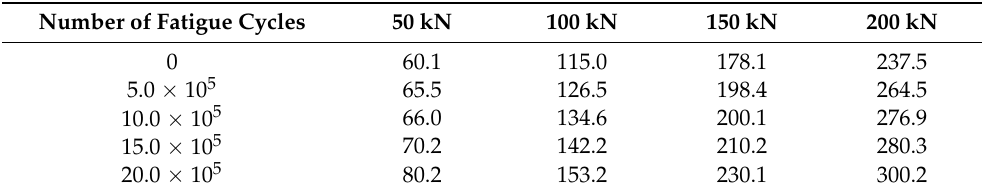
Table 7. Table of mid-span tensile strain variation with fatigue times after freeze–thaw damage of test plate strengthened with bonded steel plate ( µε ).